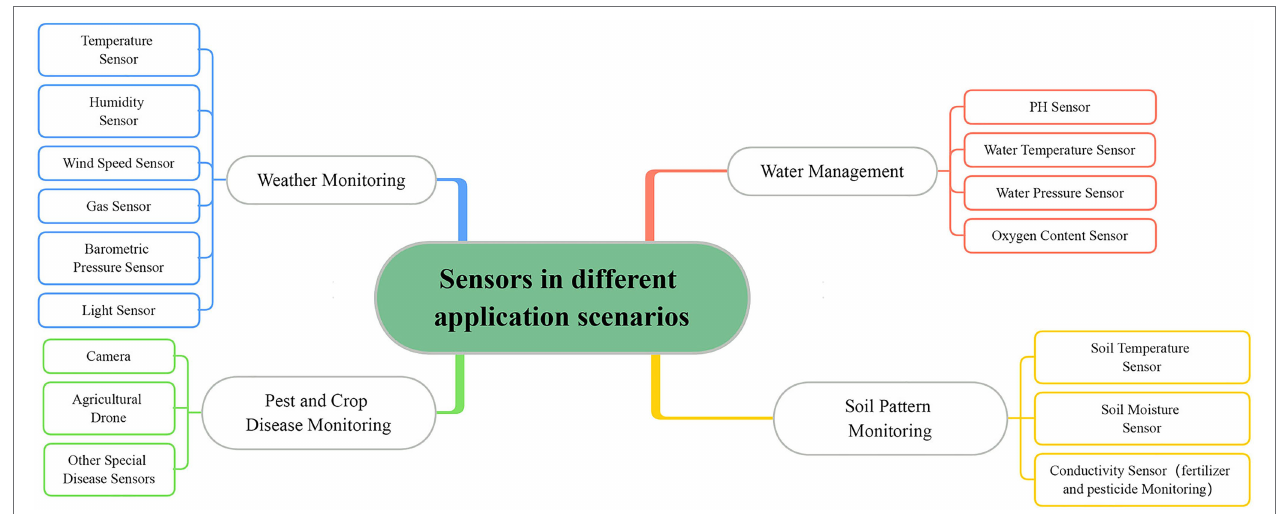
FIGURE 1 | Sensors in different application